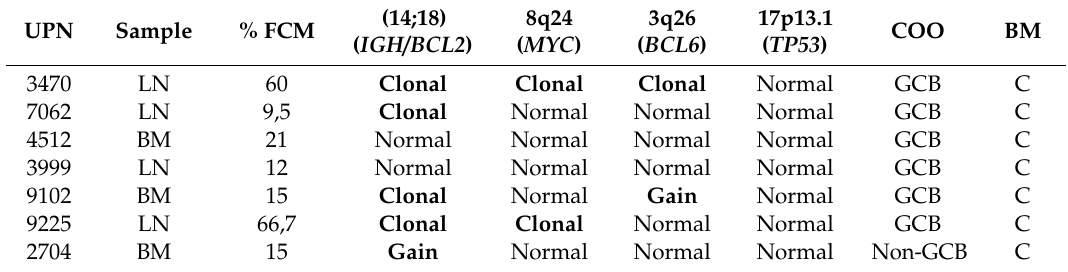
Table 3. Fluorescence in-situ hybridization (FISH) analysis of patients with involved bone